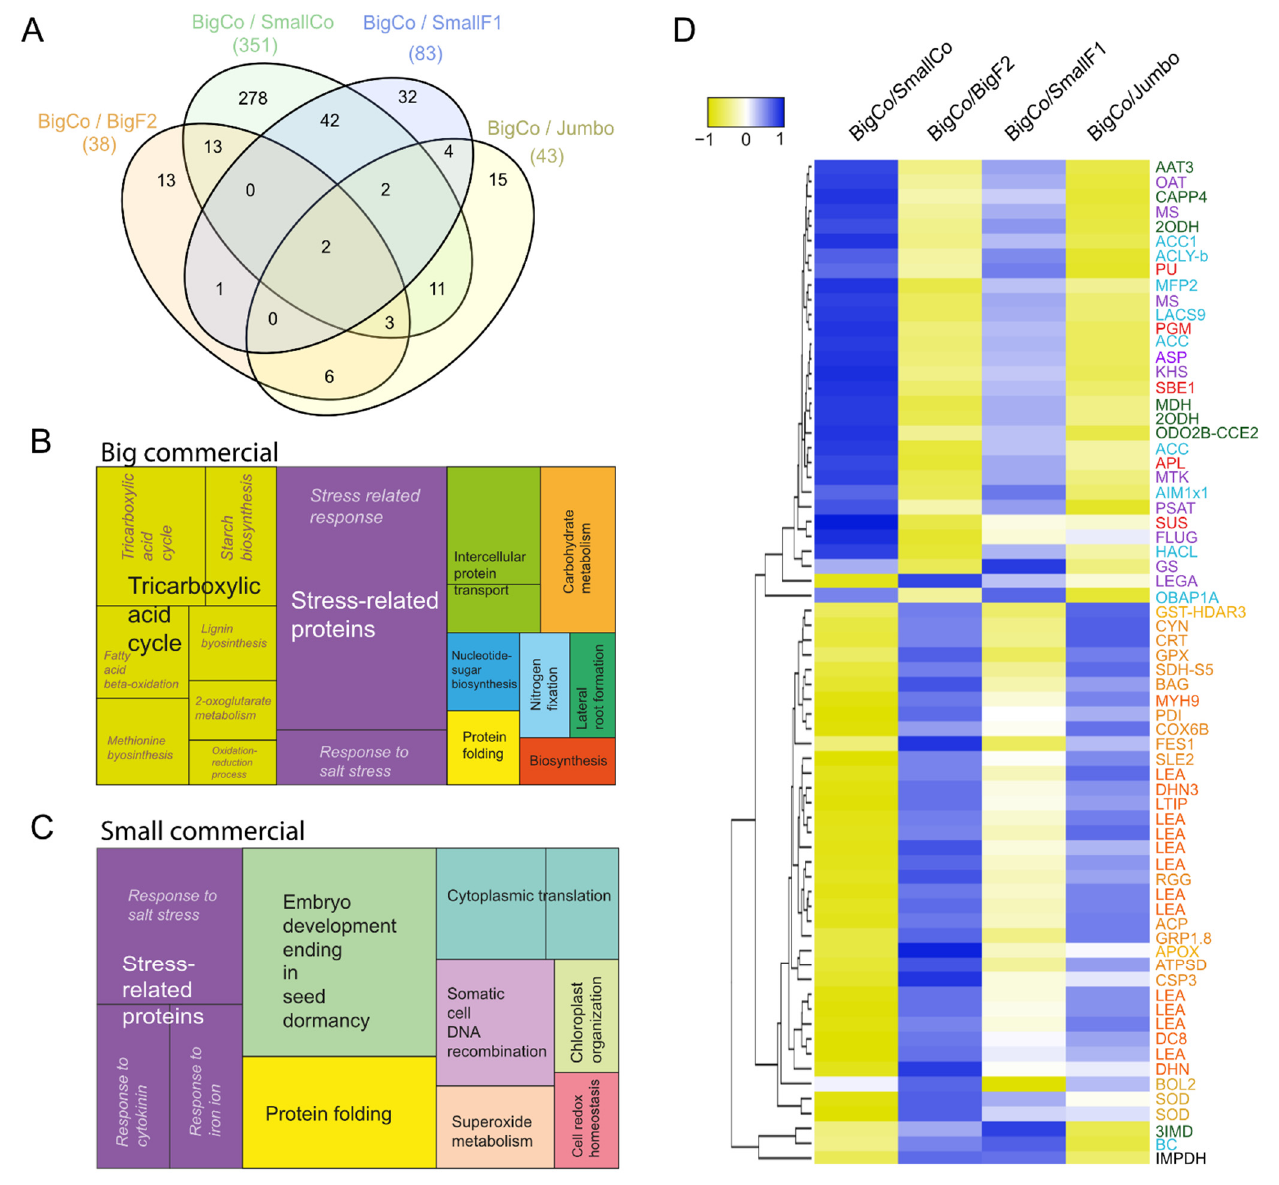
Figure 3. Functional annotation analysis-based GO enrichment of biological process and cluster analysis. Venn diagram of differential proteins identified in different comparisons between grain phenotypes ( A ). Treemap representation of the clustering information related to GO enrichment analysis of proteins over-accumulated in large ( B ) and small grains ( C ). Heatmap of differentially identified proteins across grain phenotypes ( D ). Abbreviation of proteins associated with starch is indicated in darker red, proteins related to lipid metabolism are in blue, TCA cycle proteins are in green, proteins related to amino acid metabolism are in purple, proteins associated with water deprivation and response to ABA are indicated in lighter red, ROS homeostasis is in aqua, and proteins related to stress, in general, are in orange.